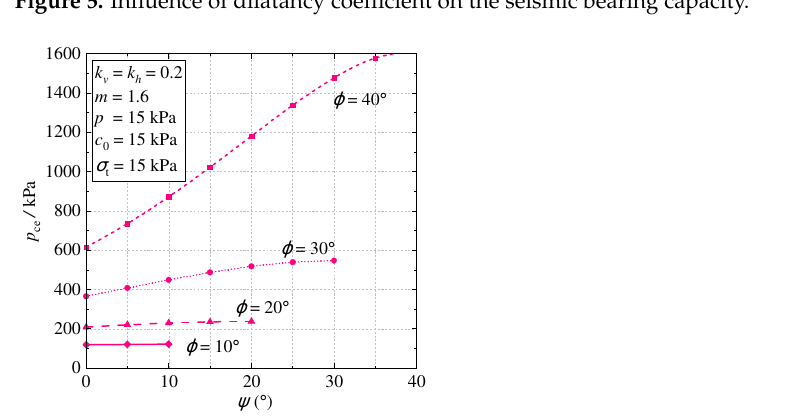
Figure 6. Values of seismic bearing capacity versus dilatancy angle and internal friction angle.